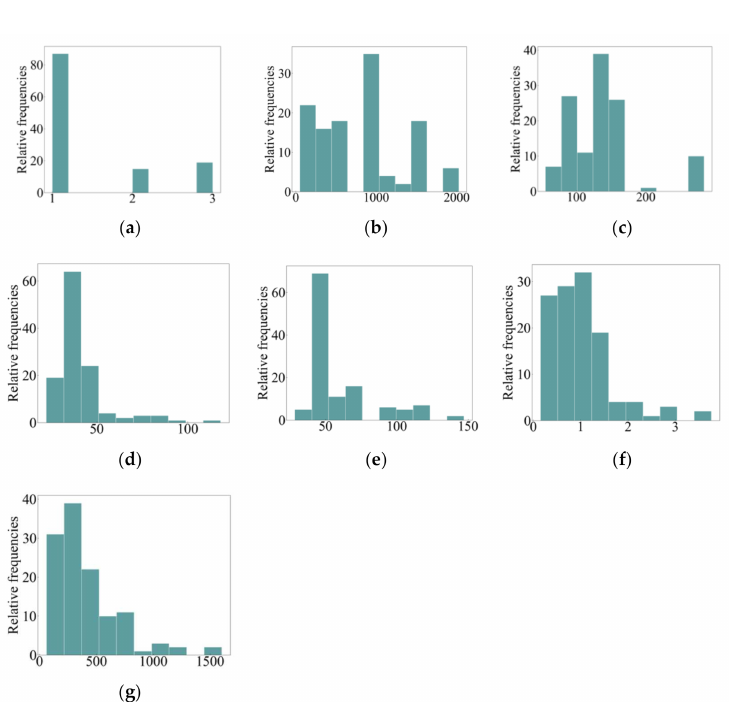
Figure 2. Histograms of input and output variables. ( a ) x 1 ; ( b ) x 2 ; ( c ) x 3 ; ( d ) x 4 ; ( e ) x 5 ; ( f ) x 6 ; ( g ) y